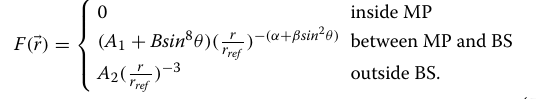
| f − f | , i , model i , data